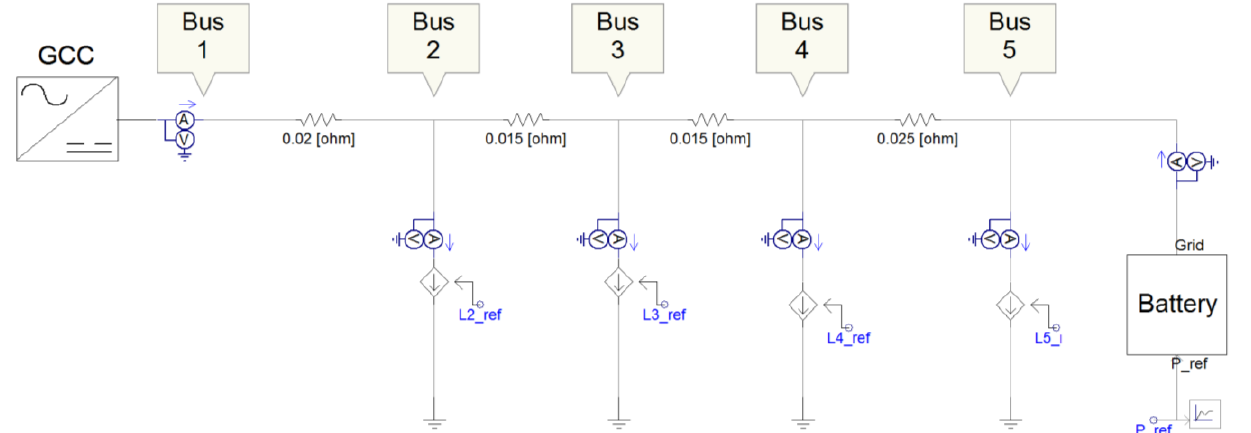
Figure 5. Test radial system for the proposed cooperative voltage control in